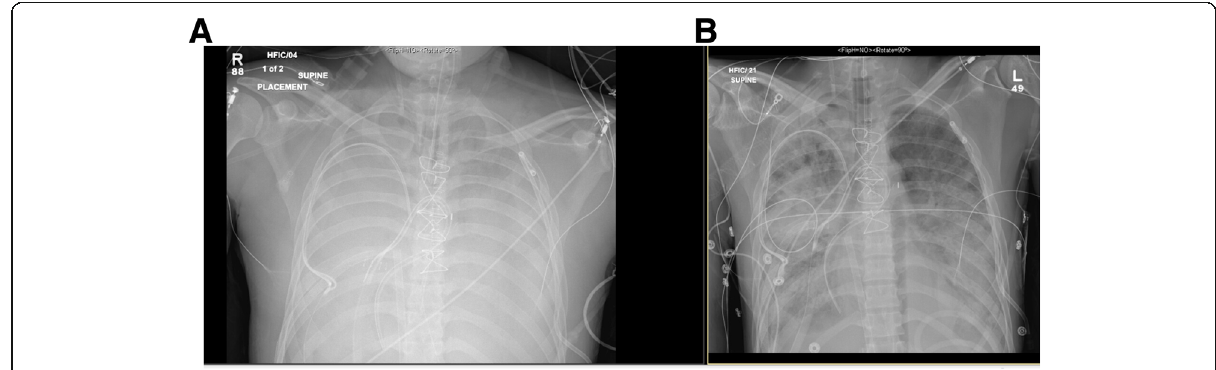
Fig. 3 a Chest x-ray on admission to ICU one day after initial CXR at admission showing diffuse infiltrates with loss of lung volumes. b Improvement in aeration noted in four days after cannulation with